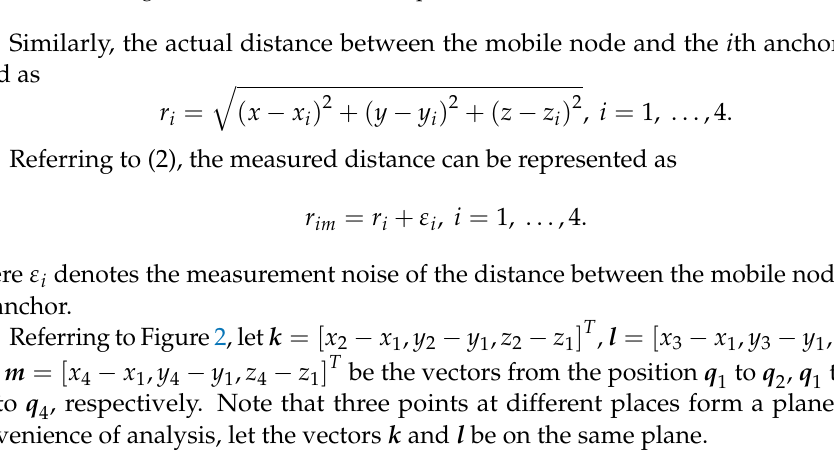
Figure 2. Positioning of a mobile node in a 3D space with 4